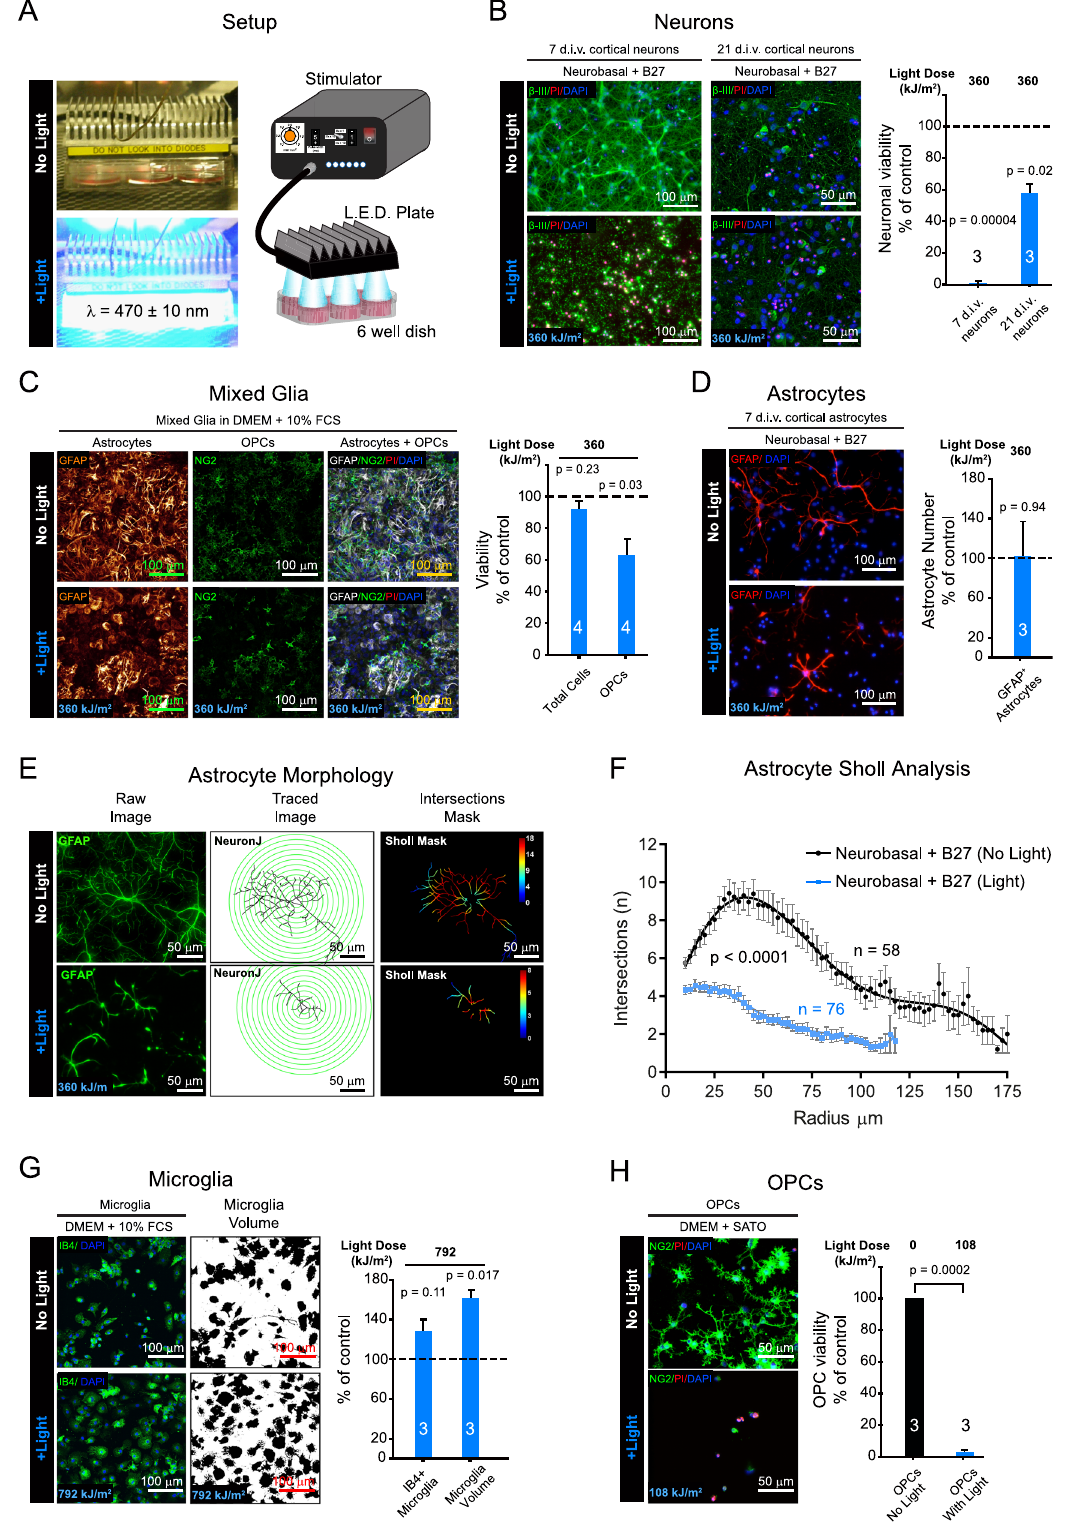
Figure 1. Light induces cytotoxicity in vitro . ( a ) Blue light (470 ± 10 nm) LED setup with control unit regulating delivery of power, pulse duration and frequency of light to cells in 6 well dish. ( b ) Viabilities of cortical neurons ( β –III-tubulin + ( β –III)) of 7 or 21 days in vitro (d.i.v.) using propidium iodide (PI) exclusion assay after ± light at indicated light dose (units of kJ/m 2 ). ( c ) Mixed glia (astrocytes (GFAP + ) and OPCs (NG2 + )) viabilities determined using PI exclusion assay after ± light treatment. ( d ) Representative images and quantification of GFAP + astrocyte numbers in 7 d.i.v. cortical neuron enriched cultures after ± light at indicated dose. ( e ) Example of astrocyte morphological tracings after ± light treatment using GFAP staining and NeuronJ